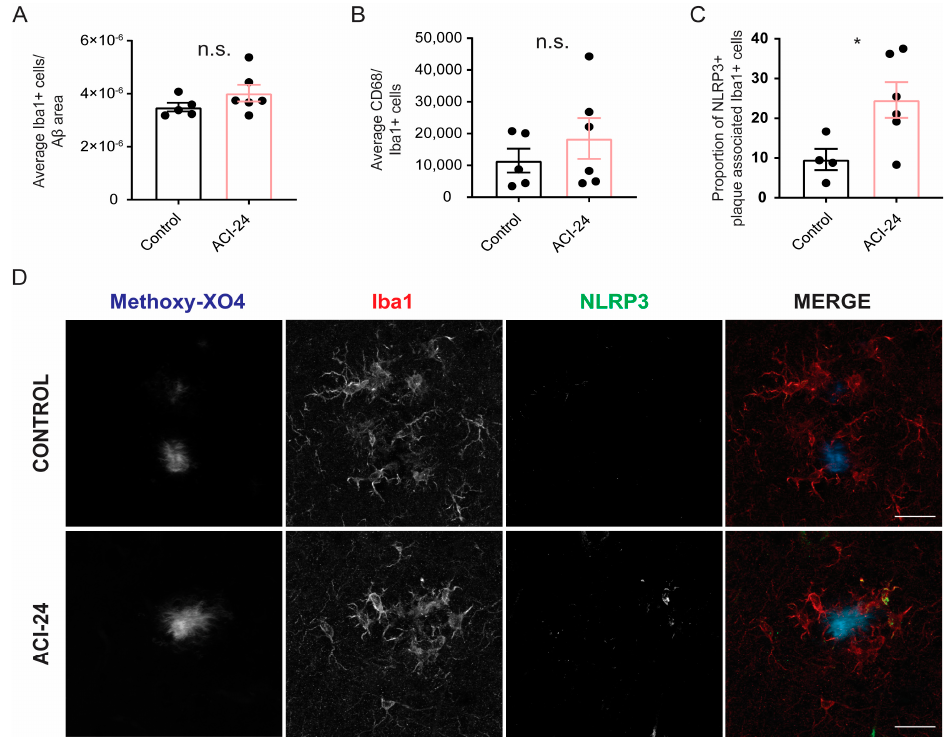
Figure 3. Increased microglial activation at A β plaques can be observed in the offspring